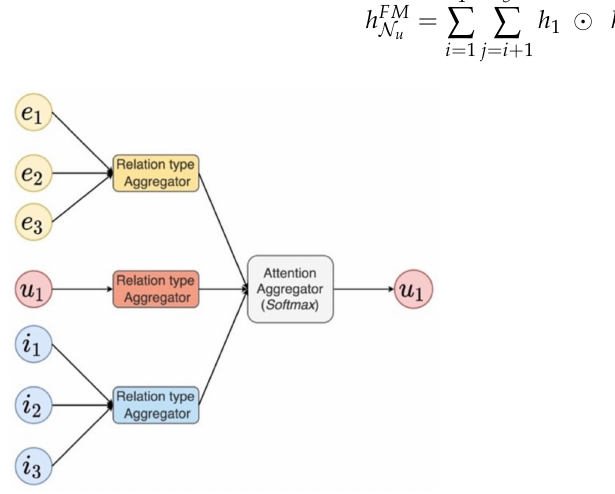
Figure 4. Attention